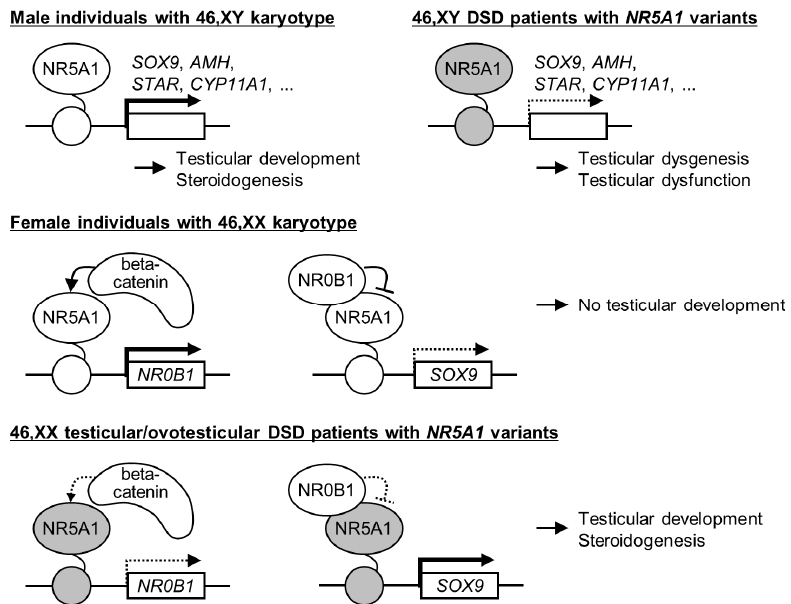
Figure 2. Putative mechanisms underlying 46,XY disorders/differences of sex development (DSD) and 46,XX testicular/ovotesticular DSD caused by NR5A1 variants. White boxes depict the target genes of NR5A1. Thick arrows indicate active transcription and broken arrows depict transcriptional suppression. NR5A1 colored in gray depicts mutant proteins. NR0B1, nuclear receptor subfamily 0 group B member 1; NR5A1, nuclear receptor subfamily 5 group A member